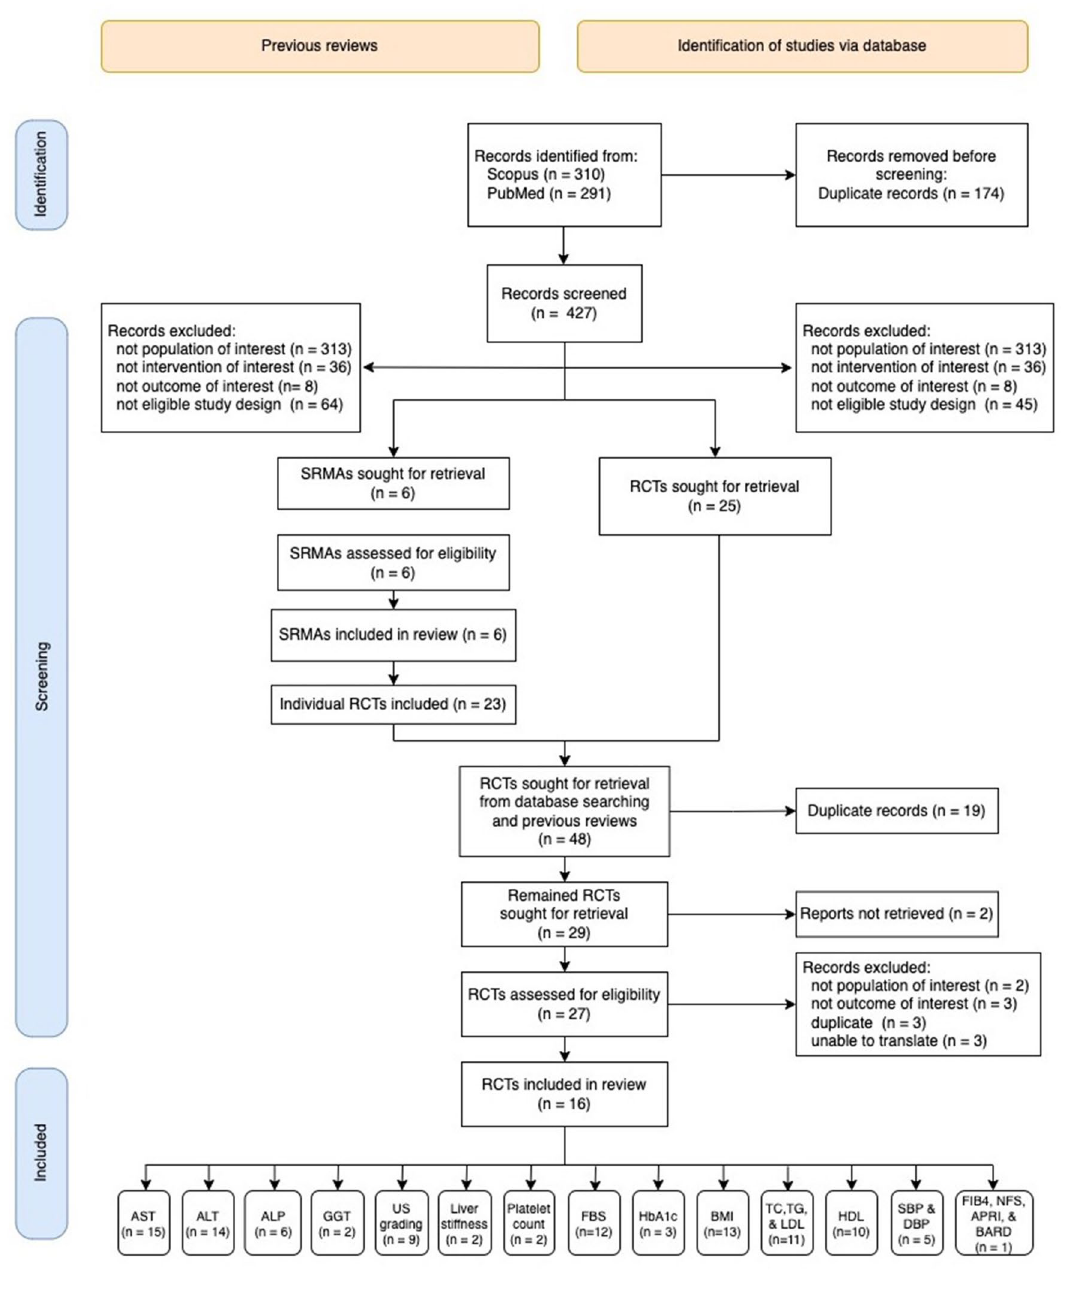
Figure 1. The PRISMA flow diagram visually summarizing the screening